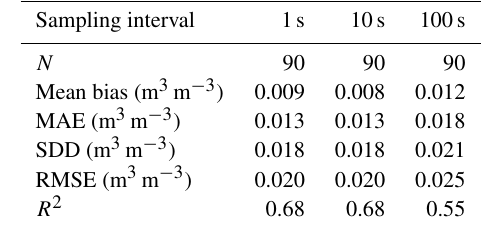
Table 5. Soil moisture scores from the comparison between daily mean in situ VSM observations at a depth of 5cm and GNSS VSM retrievals during TS4 (after grass cutting, from 9 July to 6 Octo- ber 2016). The L2C SNR data from GPS PRN 10 ascending tracks were used, which were acquired by the 3.3m antenna. MAE is the mean absolute error, RMSE is the root mean square error and SDD is the standard deviation of